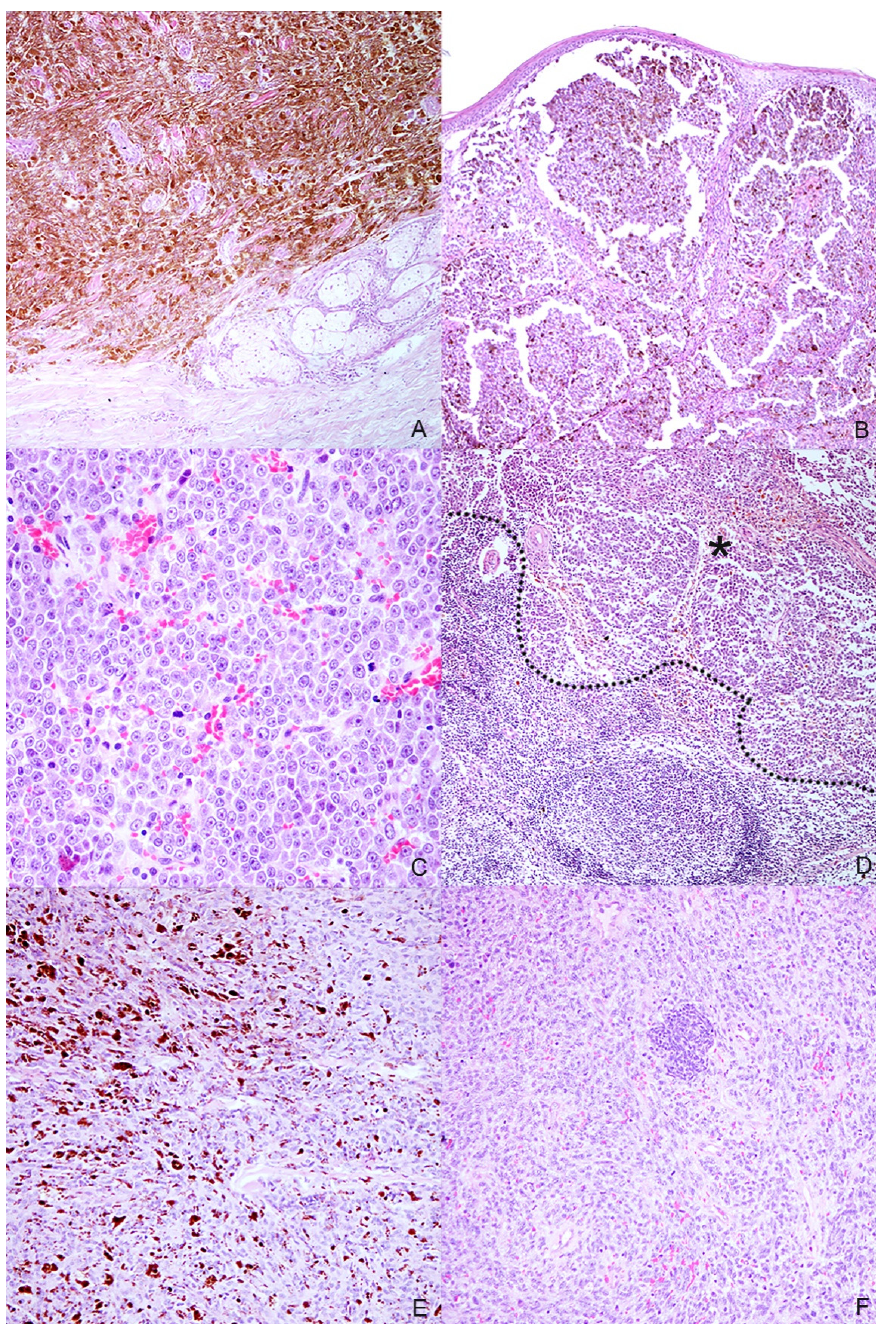
Figure 2. Histopathologic characteristics of the selected melanocytic tumors. ( A ) Case n. 1—Dermal highly cellular proliferation of pigmented melanocytes with minimal cellular atypia (H-E, 100 × ); ( B ) Case n. 2—Densely packed, moderately pigmented melanocyte proliferation infiltrating the lamina propria of the oral mucosa(H-E, 100 × ); ( C ) Case n. 3—Mucosal amelanotic melanoma: cells show large nuclei with prominent nucleoli without intracytoplasmic melanin. Note the high mitoses (H-E, 400 × ); ( D ) Case n. 3—Lymph node metastasis: the same atypical melanocytic population effacing the architecture of the lymph node (residual cortical tissue on the bottom-left of the dotted line; metastatic tumoral tissue on the asterisk) (H-E, 100 × ); ( E ) Case n. 4—Spindle-shaped, frequently pigmented melanocytes proliferation with moderate cellular atypia, localized in the dermis (H-E, 200 × ); ( F ) Case n. 5—Mucosal amelanotic melanoma: epithelioid to polygonal neoplastic melanocytes forming sheets and rare nests in the lamina propria (H-E, 200 ×